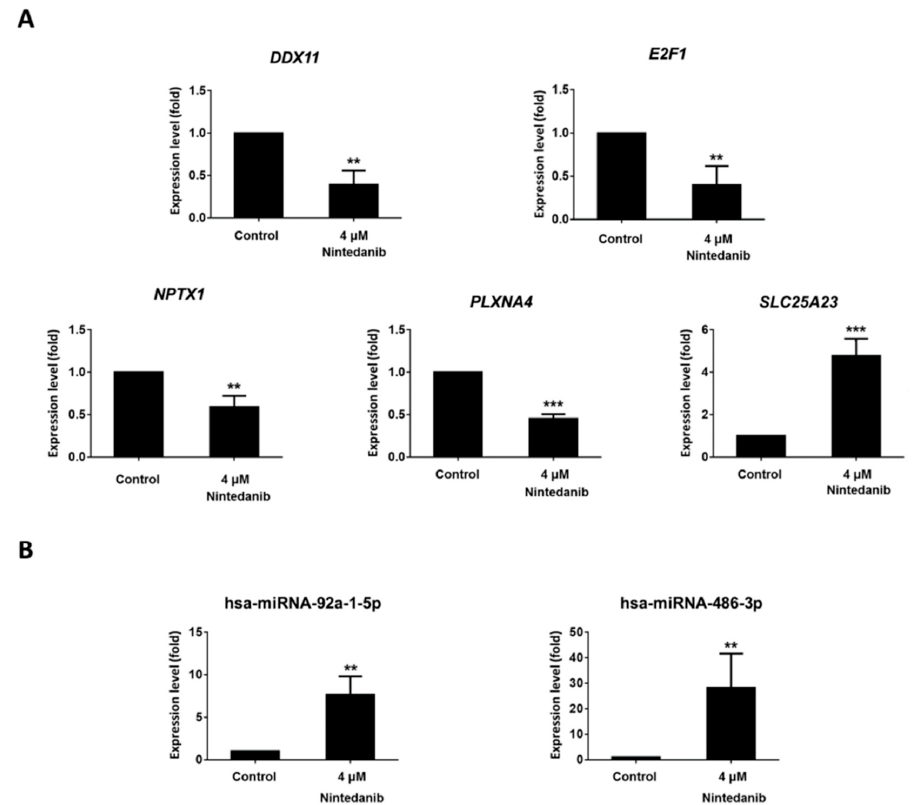
Figure 7. The expression levels of ( A ) mRNAs and ( B ) miRNAs in IPF fibroblasts treated with 0.1% DMSO (control) and 4 µM nintedanib assessed with RT-qPCR. The expression levels in nintedanib-treated IPF fibroblasts were compared to the expression levels in controls, expressed as mean ± standard error of the mean, and analyzed with Student’s t -test. ** P < 0.01; *** P < 0.001.